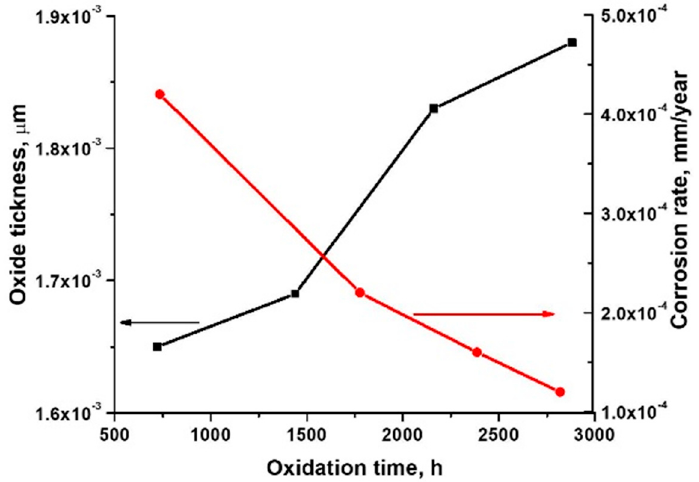
Figure 3. The behaviour of corrosion rate (red line) and oxide thickness (black line) depending on exposure period in supercritical static conditions of the CrN x -coated 310 H samples.